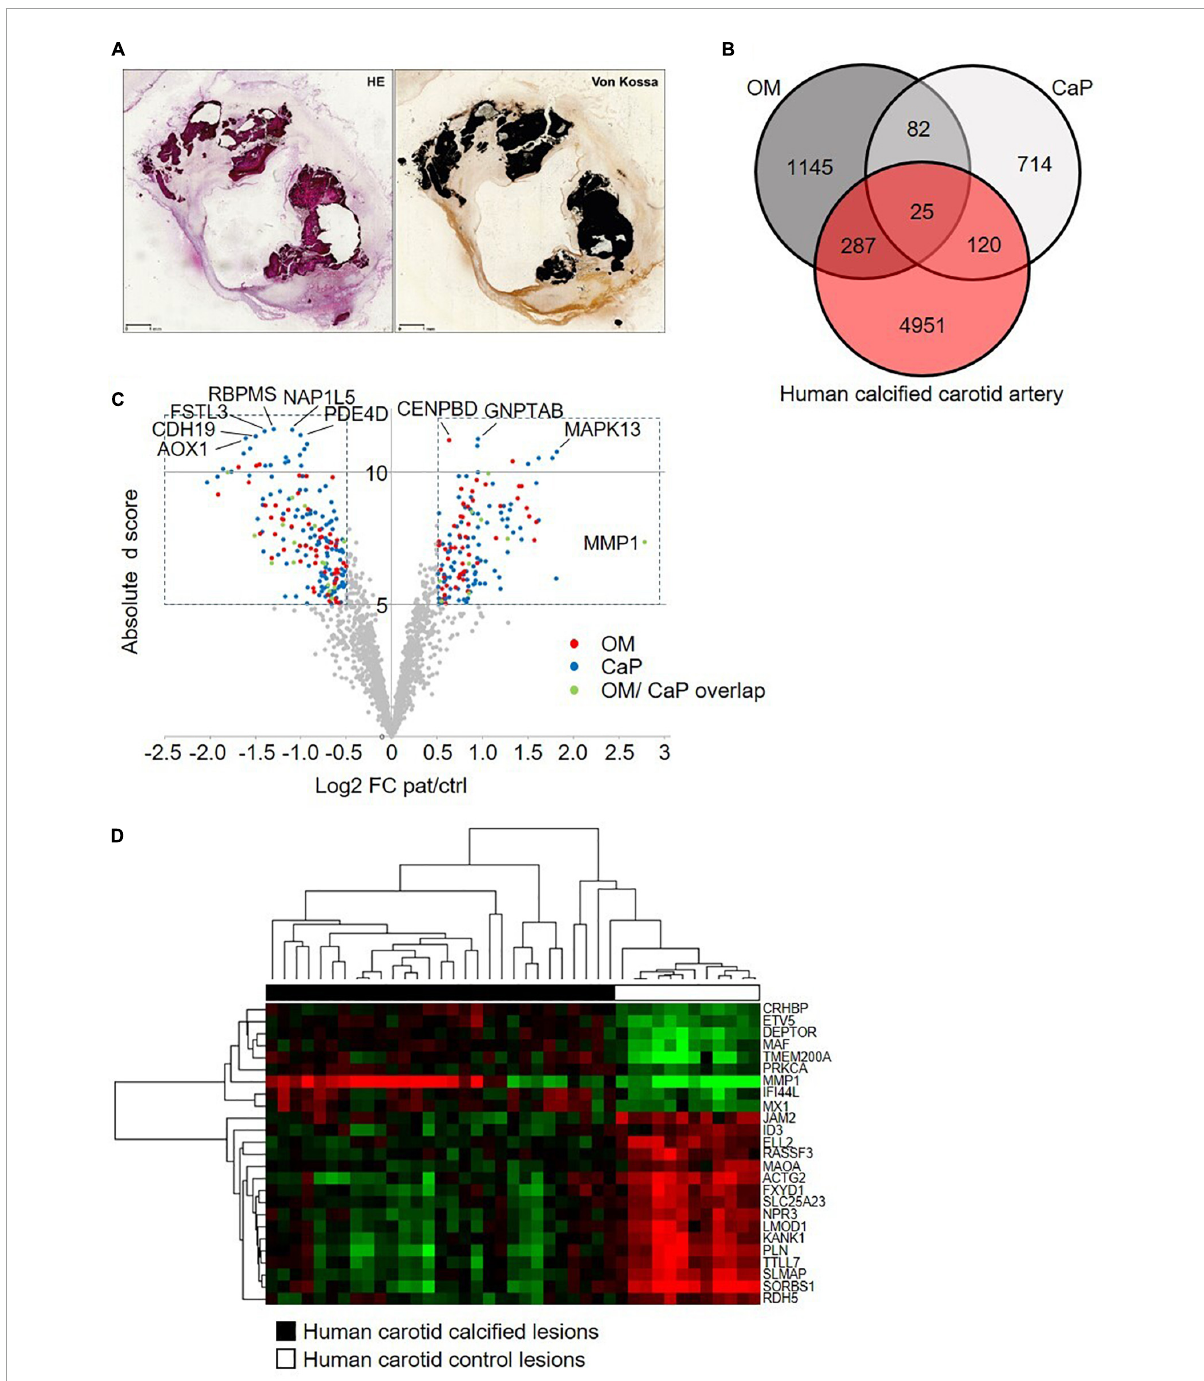
FIGURE5 Comparative transcriptome analysis across human carotid artery and in vitro models. (A) Serial sections of a resin embedded carotid lesion [hematoxylin eosin staining (HE) and von Kossa staining] Bar: 1 mm. (B) Venn diagram comparing the osteogenic media (OM)-treated primary coronary artery smooth muscle cells (pSMCs) and calcium phosphate (CaP)-treated pSMCs gene signatures to the human calcified carotid artery gene signature. (C) The volcano plot of the human calcified carotid artery dataset displays only the OM and CaP gene signature genes. Plotted on the x -axis is the log 2 of the fold change (FC) between the calcified and control carotid artery. Plotted on the y -axis is the absolute d score obtained through Significant Analysis of Microarrays ( T -statistic value). Significant differentially expressed genes (Absolute d score > 5, Log 2 FC < –0.5 or > 0.5) are indicated in red (OM genes), blue (CaP genes), or green (shared between OM and CaP). Non-differentially expressed genes are shown in gray. (D) Hierarchical clustering of the 25 differential regulated genes that are common between carotid artery, OM-calcified pSMCs, and CaP-calcified pSMCs. Green, black and red corresponds to lower, median and higher gene expression values,